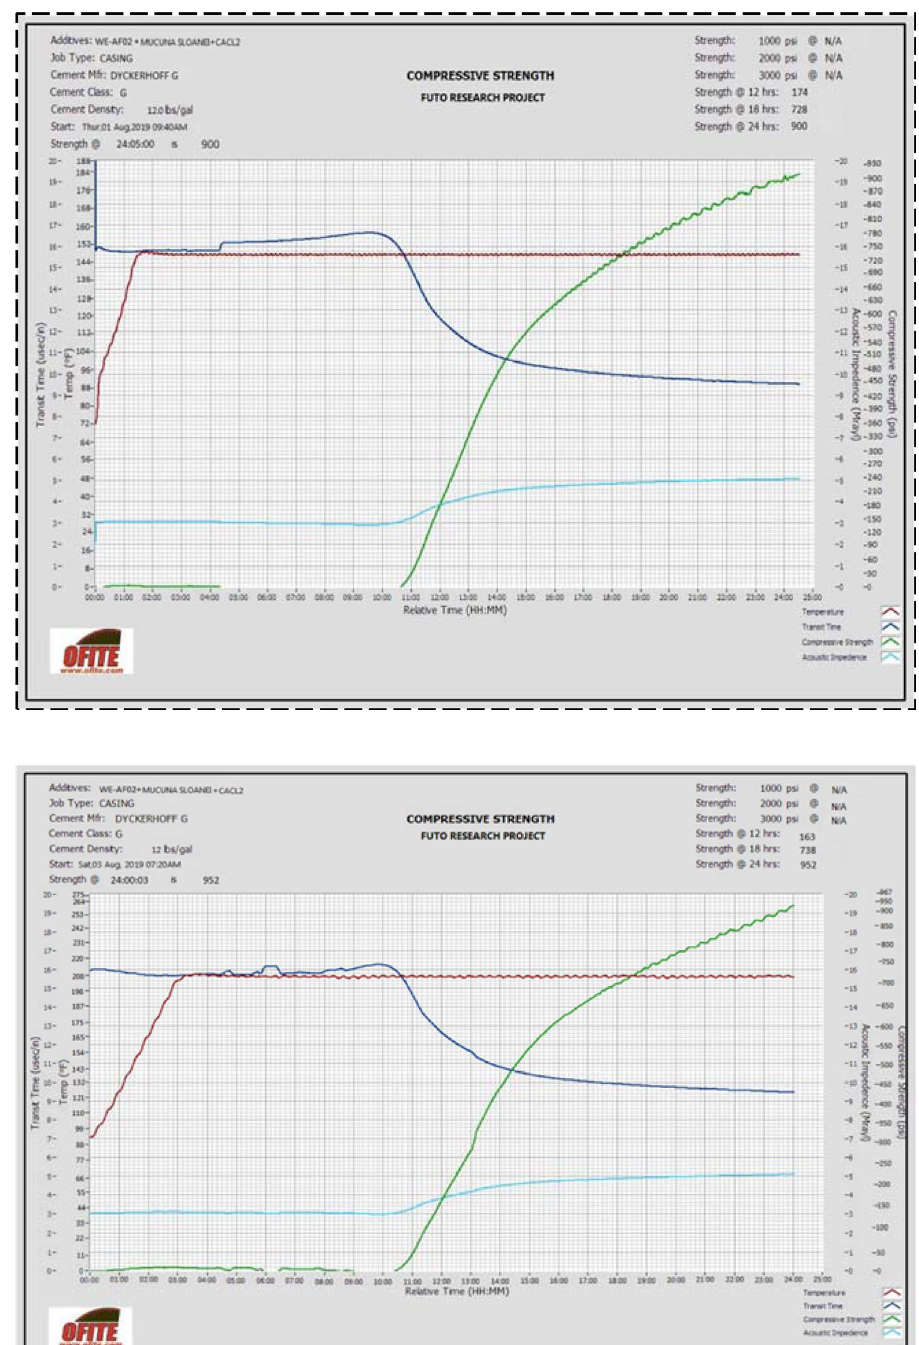
Fig. 8 Compressive strength chart for Mucuna solannie at 200 °F (93.3 °C)